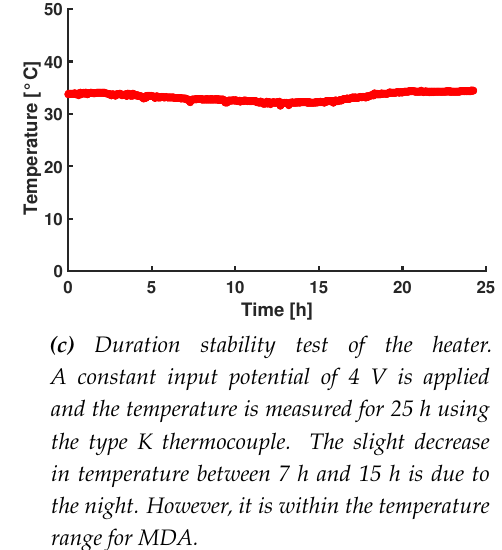
Figure 11. Characterization of the 100 nm thick Au heater structure deposited by sputtering using the two sequential shadow masks. Panel ( a ) depicts the thermal images on the other side of the 1.5mm thick substrate, while operating the heater at different input powers. ( b ) The graph with the recorded heat profiles of panel ( a ). Panel ( c ) shows the durability test in which a constant potential is applied for 25h.